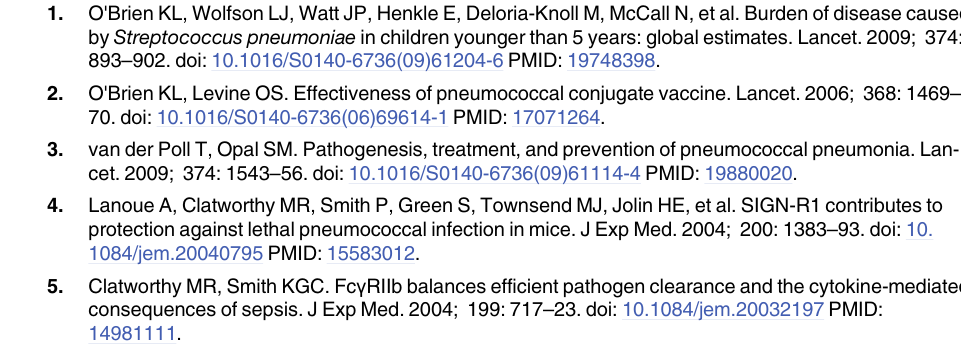
S2 Fig. Co-localization of PSGL-1 and S . pneumoniae . Local co-localization of FAM-SE S . pneumoniae (green), Cellular DNA (blue) and PSGL-1 (red) is shown and quantified by plot- ting the fluorescence intensity and the distance (in μ m). (TIF) S3 Fig. Previous exposure of HL-60 cells to LytA impairs the uptake. (A) Blockage of PSGL- 1-mediated phagocytosis by preincubation with purified LytA. HL-60 cells were incubated for 1 h with 0.1 μ g/ml or 0.01 μ g/ml of purified LytA (open bars) or without LytA (black bar) before infection with D39 strain. (B) Example of flow cytometry histogram of cells incubated with (red) or without (green) LytA. Error bars represent the SDs and asterisks indicate statistical sig- nificance of pneumococcal phagocytosis by HL-60 cells preincubated with purified LytA in comparison to incubation without LytA. (TIF) S1 Movie. Recognition and phagocytosis of S . pneumoniae is enhanced when PSGL-1 is fully functional. HL-60 cells with the PSGL-1 active were infected for 30 min with the D39 strain expressing GFP and visualized by live imaging confocal microscopy and environmental control. Bacteria are markedly recognized and trapped by the cells. (MPG) S2 Movie. Recognition and phagocytosis of S . pneumoniae is impaired when PSGL-1 is blocked. HL-60 cells with the PSGL-1 blocked by KPL-1 treatment for 1h were infected for 30 min with the D39 strain expressing GFP and visualized by live imaging confocal microscopy and environmental control. Bacterial uptake is impaired and S . pneumoniae diverts the phago- cytosis process very efficiently.